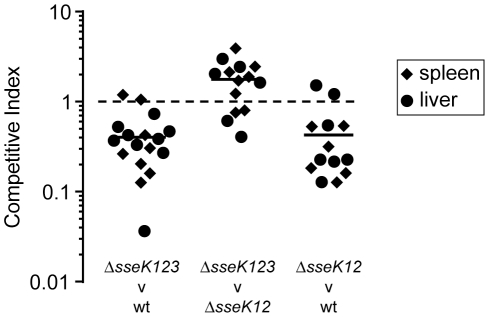
The role SseK effector in virulence.Competitive indices were determined 3 days following oral inoculation of 129/svImJ mice infected with an equal mixture of the indicated 2 strains. Values from spleen and liver for individual mice are shown as diamonds and circles respectively, and the mean is shown as a horizontal bar.